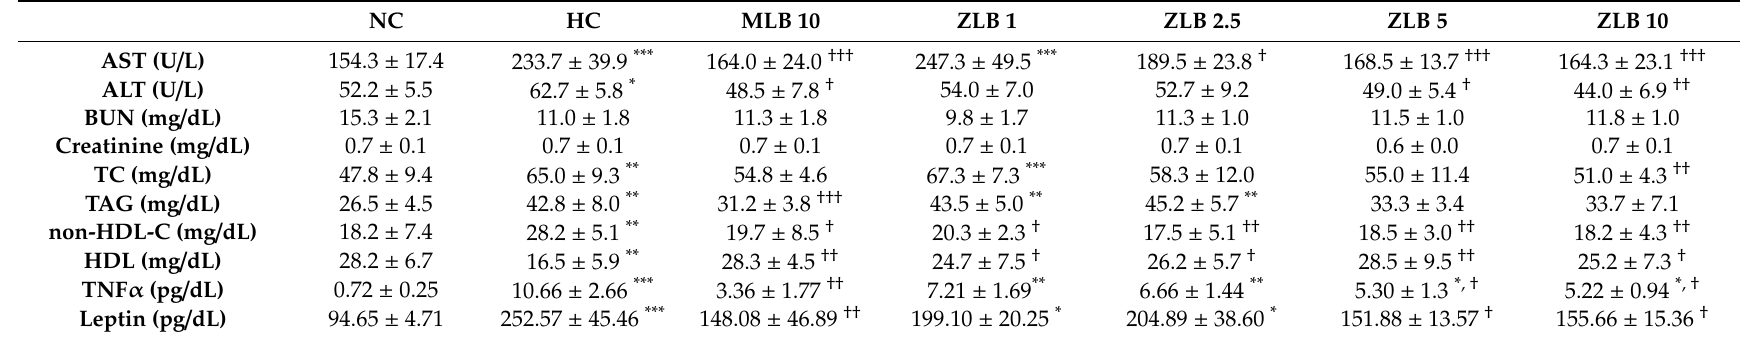
Table 2. E ff ects of ZLB on biochemical parameters in rats fed a normal diet or a high-fat diet for 4